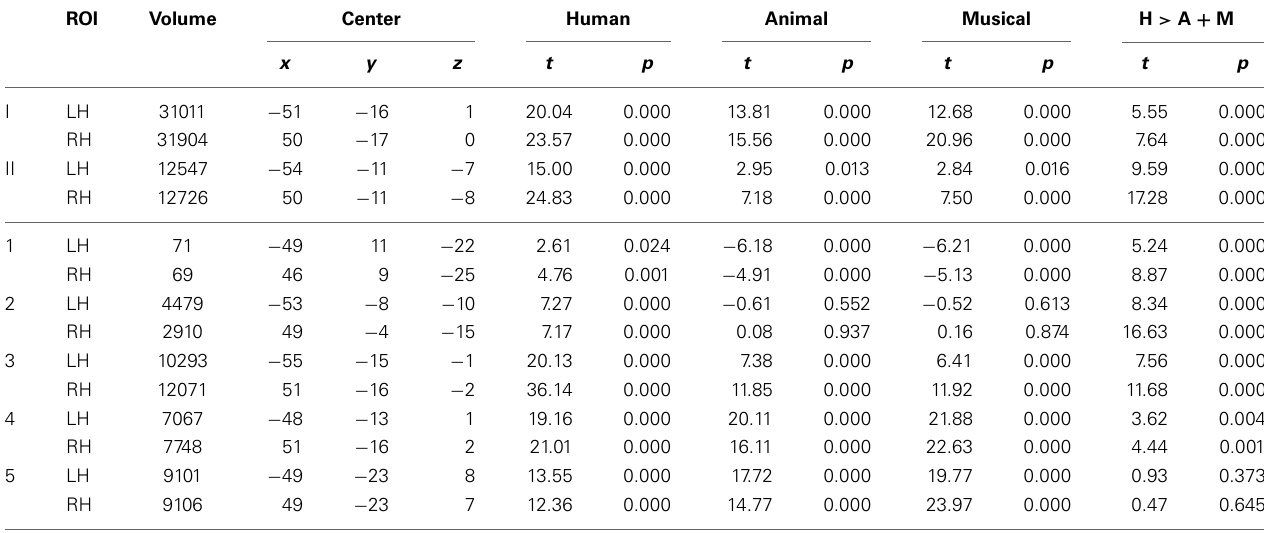
Table 4 | Details for the regions of interest identified by the multi-subject